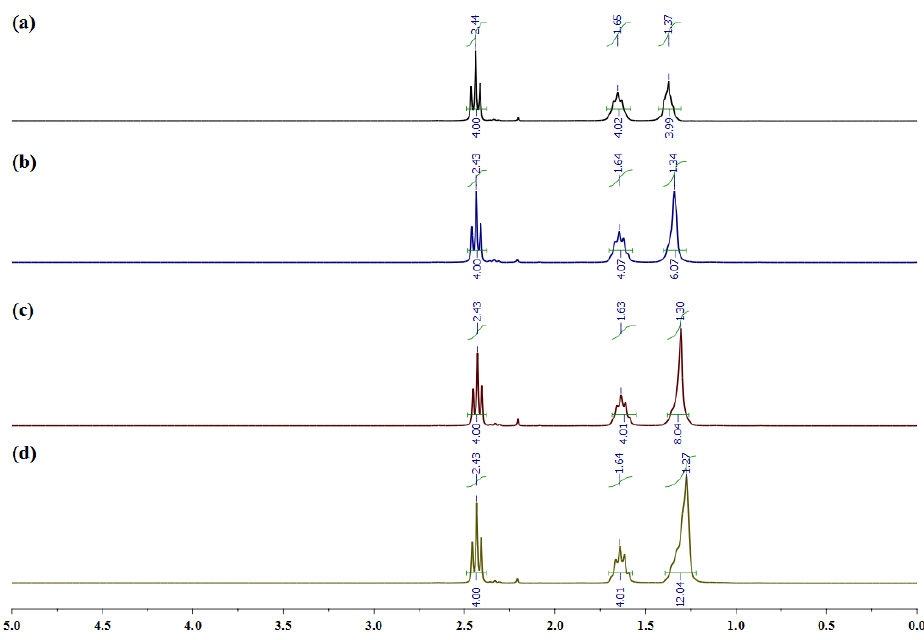
Figure 2. 1 H NMR spectra of ( a ) poly(suberic acid), ( b ) poly(azelaic acid), ( c ) poly(sebacic acid) and ( d ) poly(dodecanedioic acid). Polyanhydrides synthesized in triplicate using 1 equiv. of acetic anhydride with respect to the acid groups, at 160 °C under vacuum (~10 m bar) for 4 h.